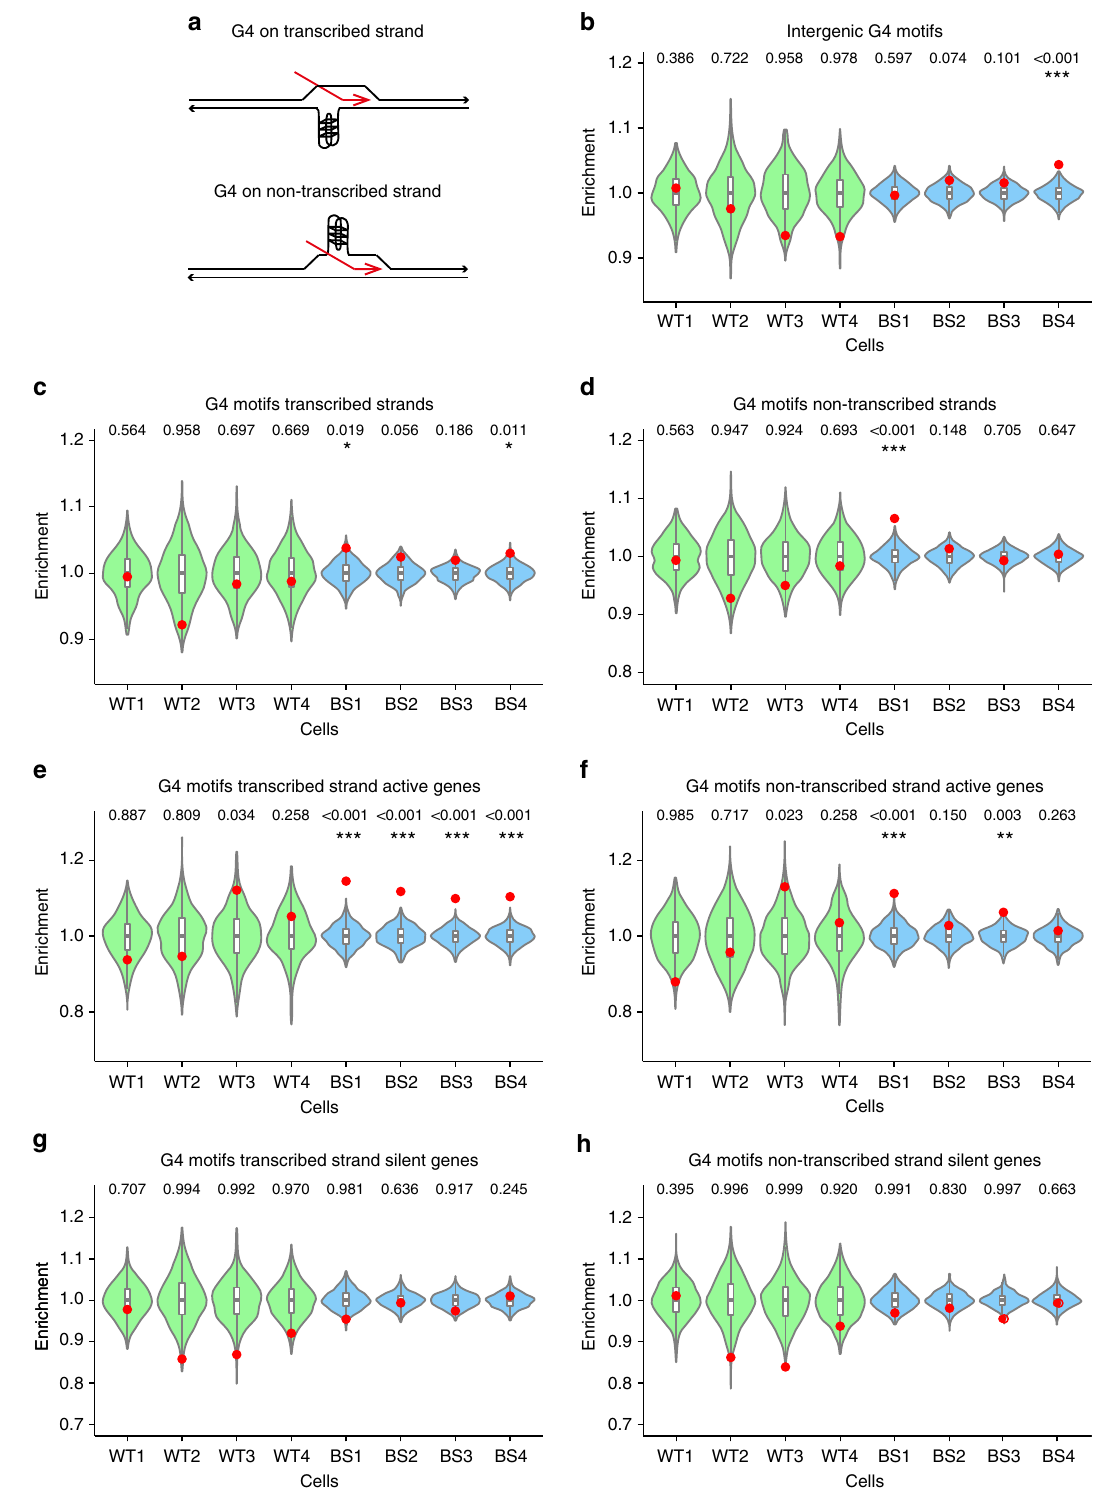
Fig. 3 Bloom syndrome SCE enrichments occur at transcribed G4 motifs. a Intragenic G4 motifs can occur on either the transcribed strand (RNA shown in red), or on the non-transcribed strand; b – h relative SCE enrichments (red points) over random distributions (violin plots) for SCEs overlapping with h for intergenic G4 motifs, and G4 motifs occurring on c intragenic transcribed strands; d non-transcribed strands; e transcribed strands of active genes; f non- transcribed strands for active genes; g transcribed strands for silent genes; and h non-transcribed strands for silent genes. p -values indicate the fraction of permuted overlaps (out of 1,000 permutations) equal to or higher than overlap with observed SCE regions. Signi fi cant p -values are indicated as follows: * p < 0.05, ** p < 0.01, *** p <